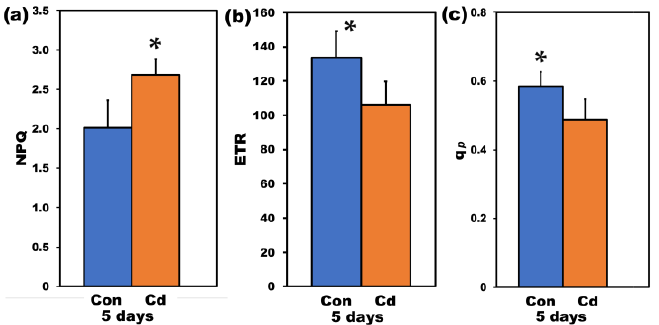
Figure 8. The non-photochemical fluorescence quenching (NPQ) ( a ), the relative PSII electron transport rate (ETR) ( b ), and the relative reduction state of Q A , reflecting the fraction of open PSII reaction centers ( q P ) ( c ), measured at 900 μmol photons m −2 s –1 ; of control (con) and 5 days Cd- treated Salvia sclarea plants. Error bars are standard deviations ( n = 6). Means between the two treatments that are statistically different ( p < 0.05) are marked by an asterisk (*).